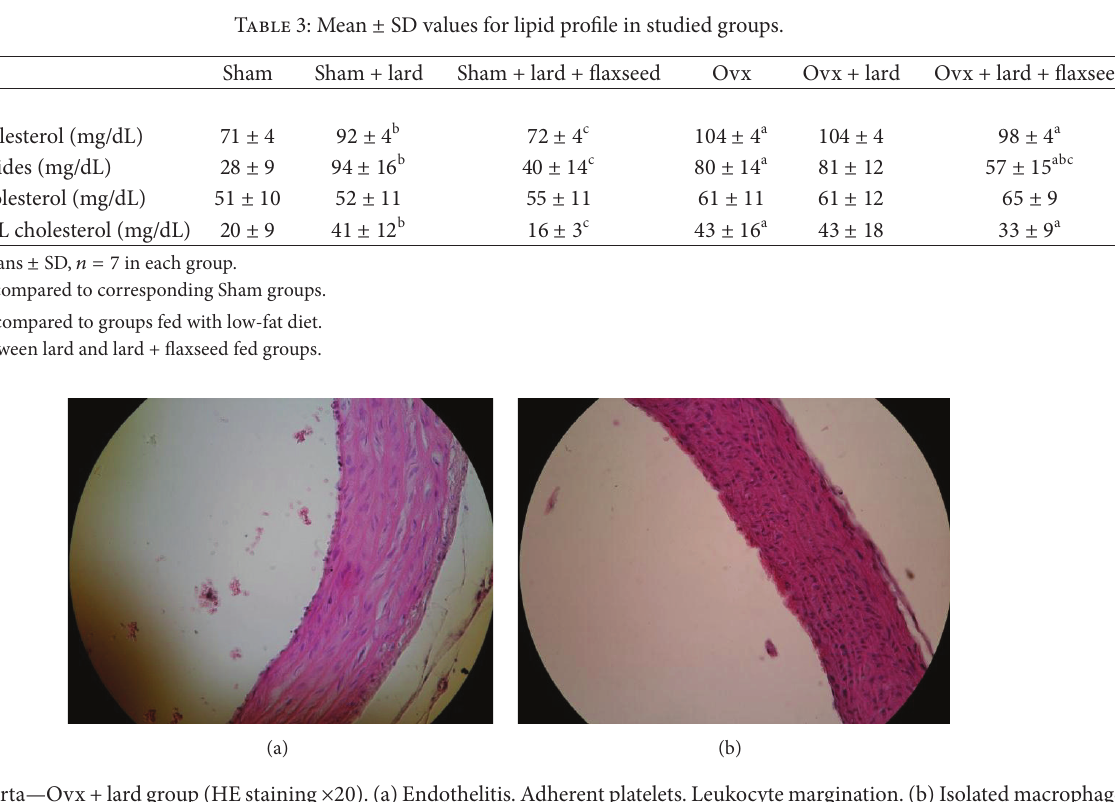
Figure 1: Aorta—Ovx + lard group (HE staining × 20). (a) Endothelitis. Adherent platelets. Leukocyte margination. (b) Isolated macrophages loaded with lipids in the internal third of the